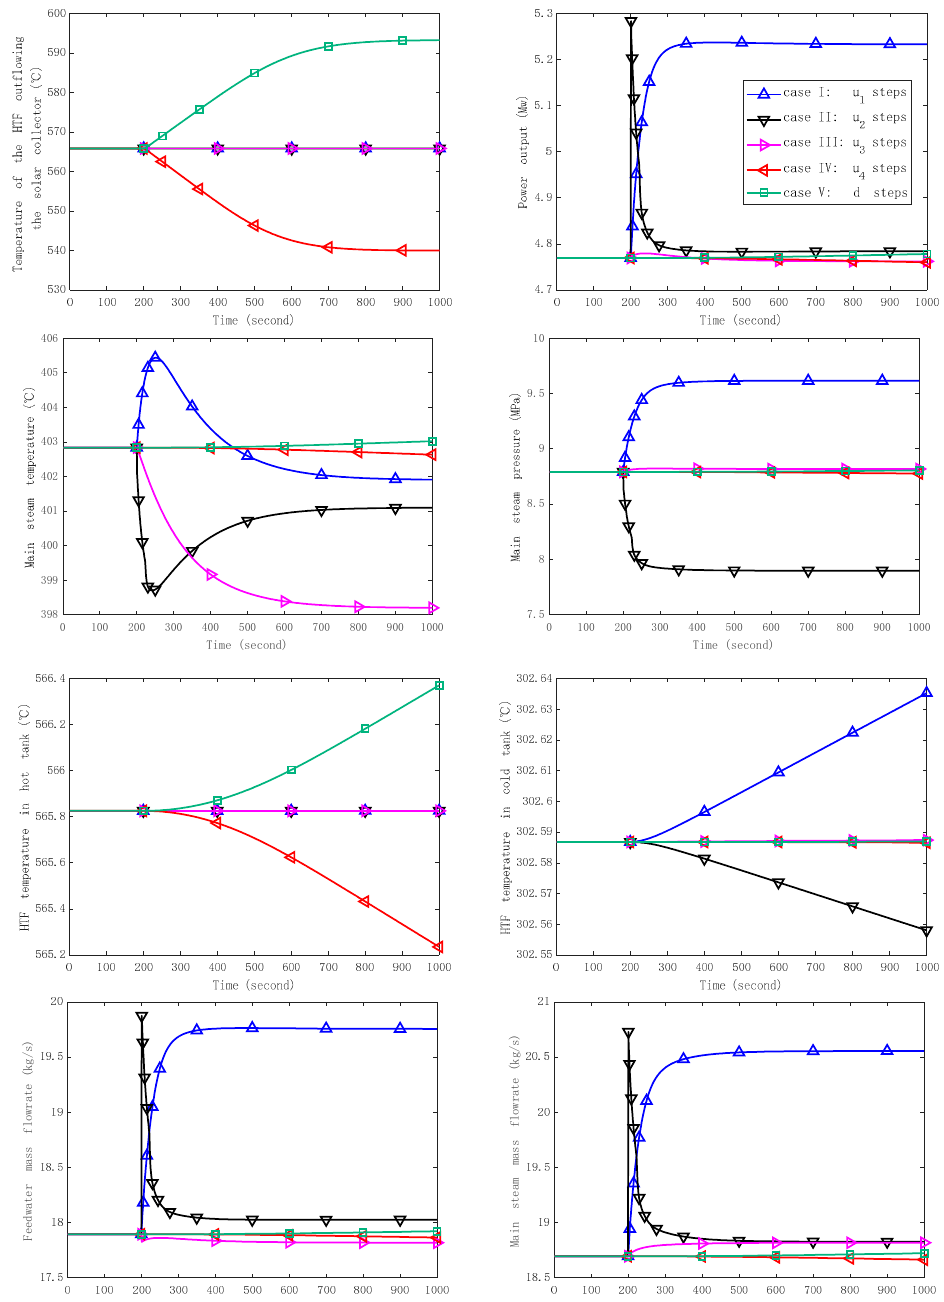
Figure 3. Simulation results of the step response (the legend on the top right side is applied to all the pictures in Figure 3).